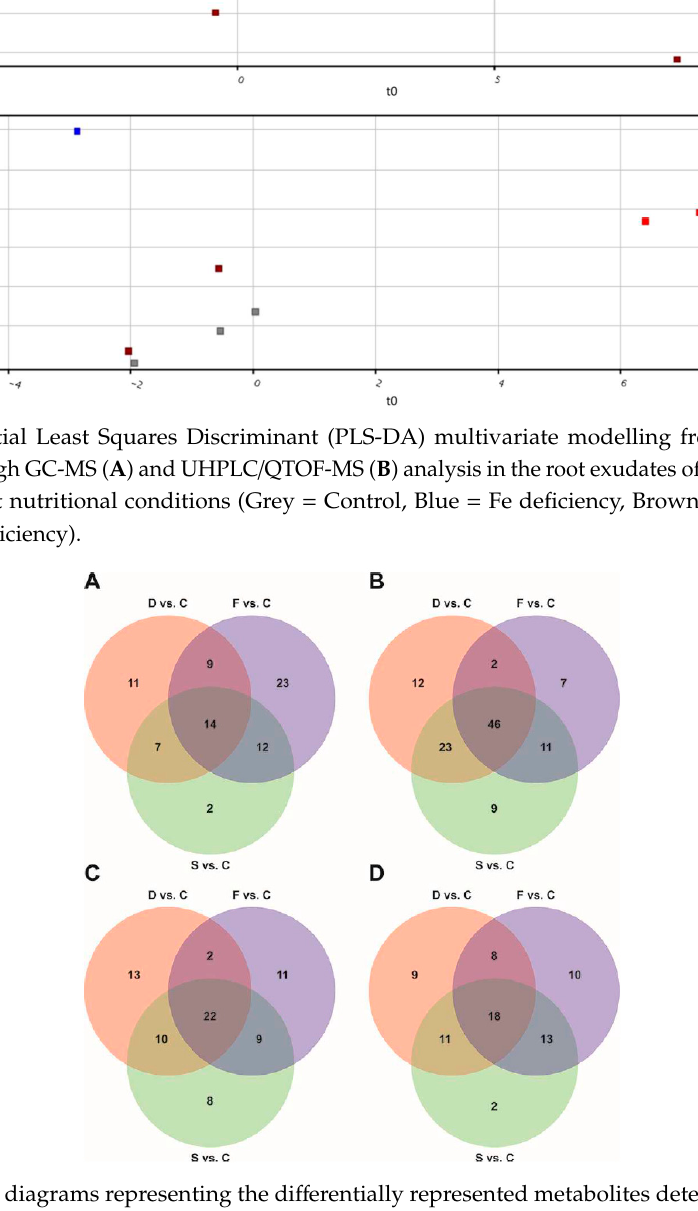
Figure 3. Partial Least Squares Discriminant (PLS-DA) multivariate modelling from the dataset obtained through GC-MS ( A ) and UHPLC/QTOF-MS ( B ) analysis in the root exudates of plants exposed to the different nutritional conditions (Grey = Control, Blue = Fe deficiency, Brown = S deficiency, Red = dual deficiency).